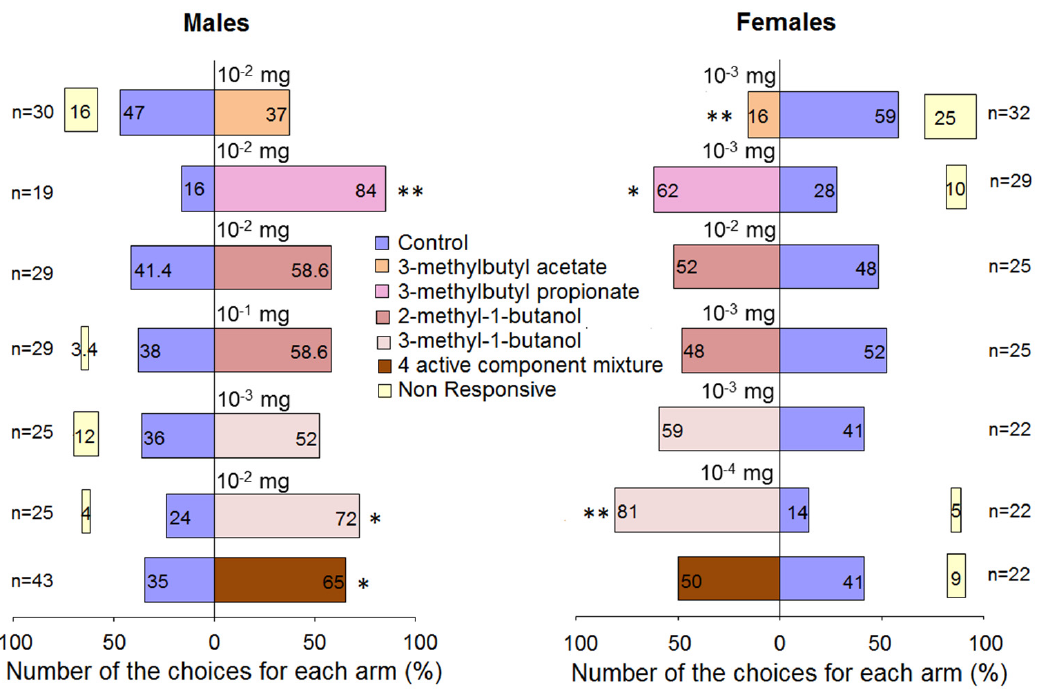
Figure 6. Behavioural responses of Rhagoletis cerasi flies in Y-tube olfactometer to EAD active volatiles. The mixture consisted of 3-methylbutyl acetate 0.55 mg, 3-methylbutyl propionate 0.05 mg, 2-methyl-1-butanol 0.012 mg, and 3-methyl-1-butanol 0.28 mg. n–number of flies tested. Stars denote significant differences in behavioural responses of flies between stimulus and control: * p < 0.05 and ** p < 0.01 by χ 2 test.